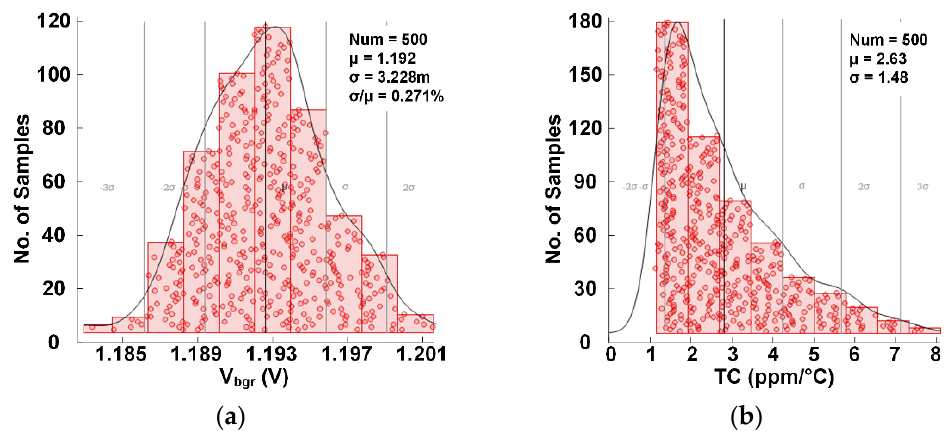
Figure 9. Statistics of untrimmed Vbgr from a 500-run Monte-Carlo simulation. ( a ) V bgr @ 27 °C; ( b ) TC in ppm/°C of V bgr .